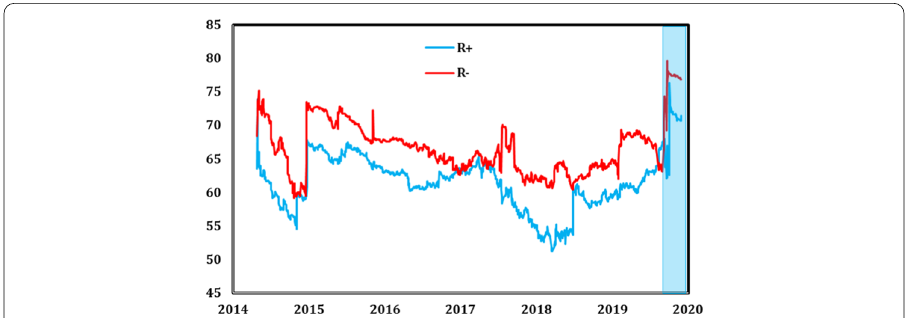
Fig. 6 Total dynamic spillover of positive (R the period of the COVID-19